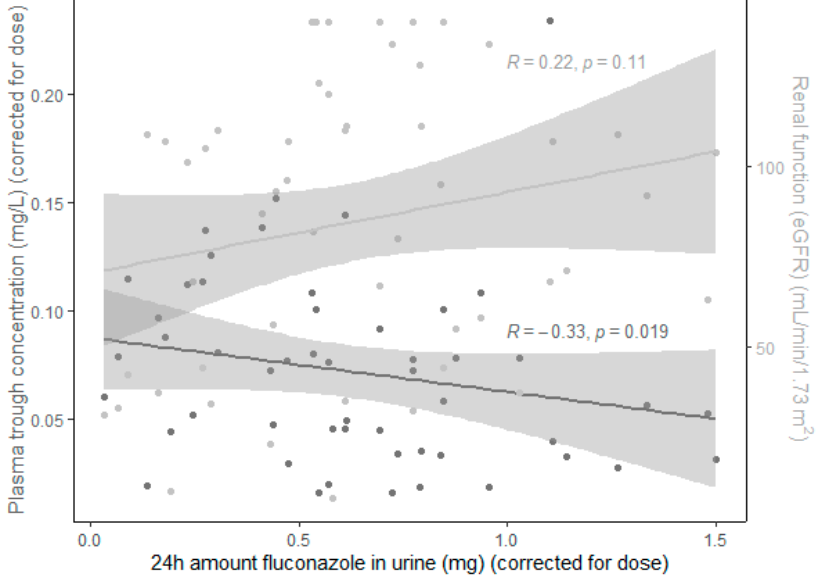
Figure 3. Correlation between fluconazole and renal function. Regression line, Spearman correlation coefficient, and p -value of the correlation between the amount of fluconazole (mg) found in the urine following a 24 h collection period (corrected for the administered dose) and both the fluconazole plasma trough concentration (corrected for the administered dose, dark grey) and the renal function (eGFR, light grey).